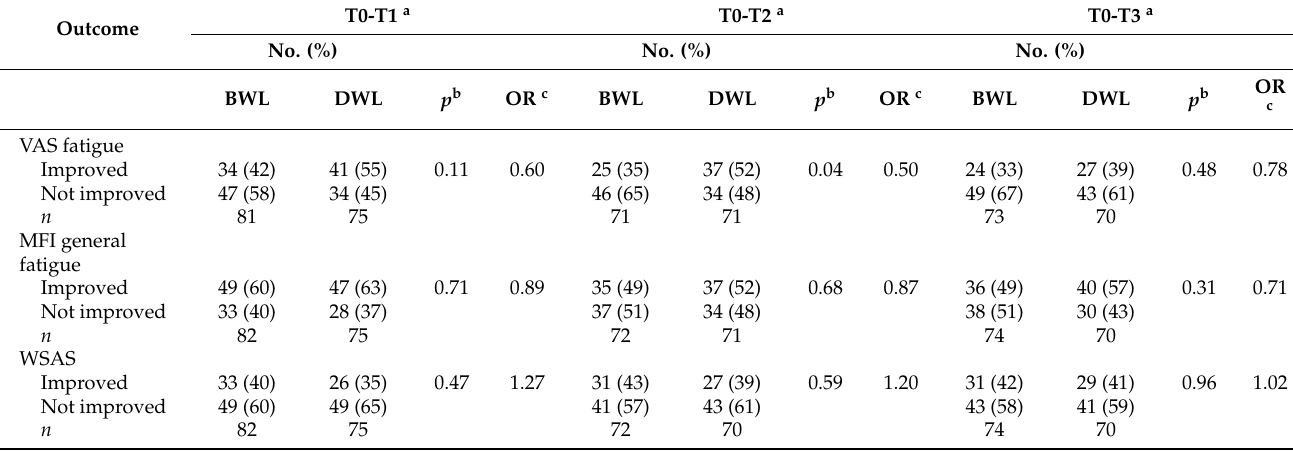
Table 4. Number (percentage) of participants with clinically meaningful improvement based on fatigue